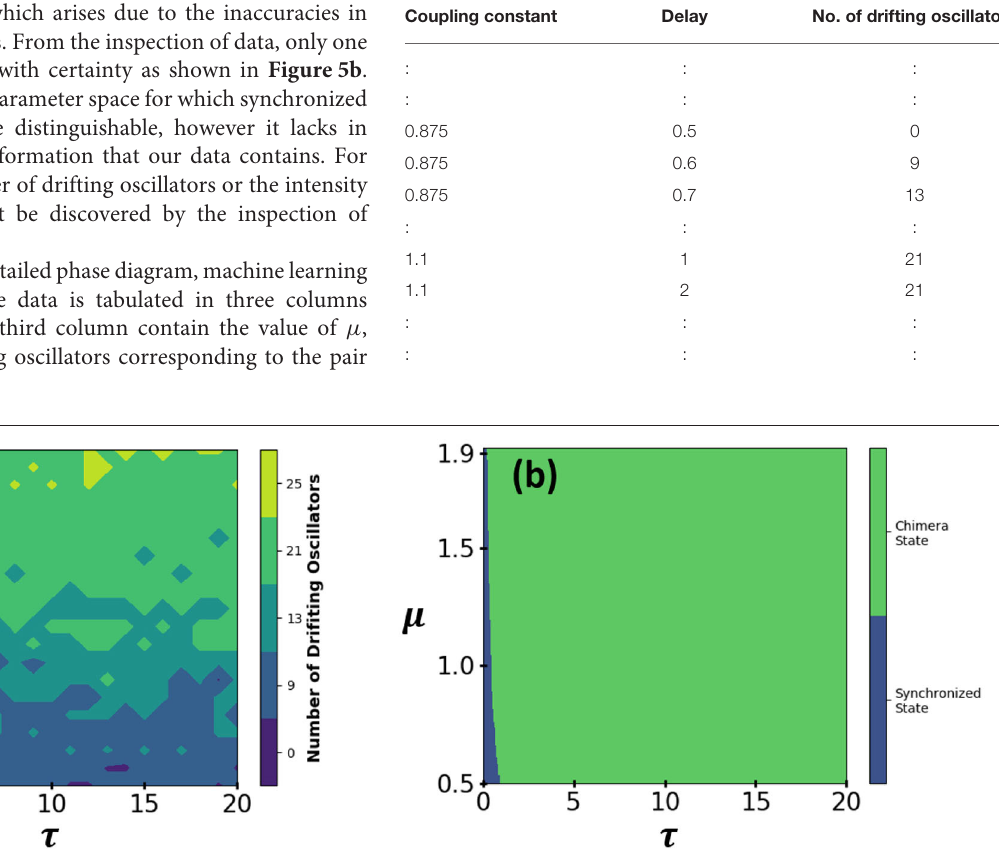
FIGURE 5 | (a) Phase diagram for 2D lattice in two parameter space of τ and µ . This phase diagram is plotted using the data which is directly obtained from the simulations. (b) This is a filtered version of (a) . All the regions in (a) with positive values for “number of drifting oscillators” are merged here to form green region, which represents chimera state. The number of drifting oscillators in blue region is zero, which represents a synchronized state.